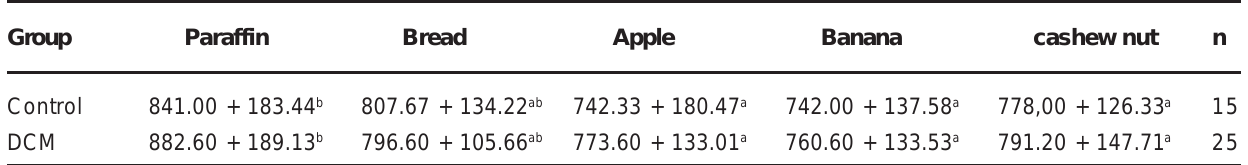
Groups with the same letters are not statistically different.